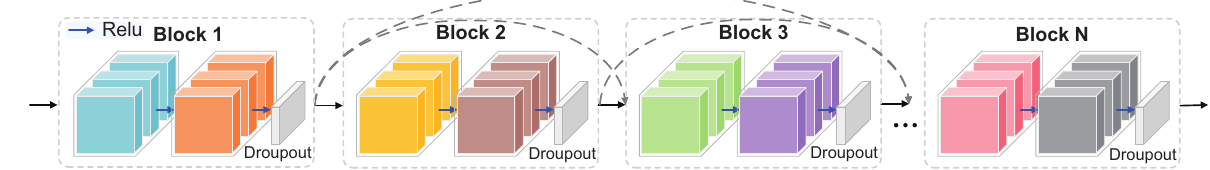
Figure 6. Densely connected convolution module.